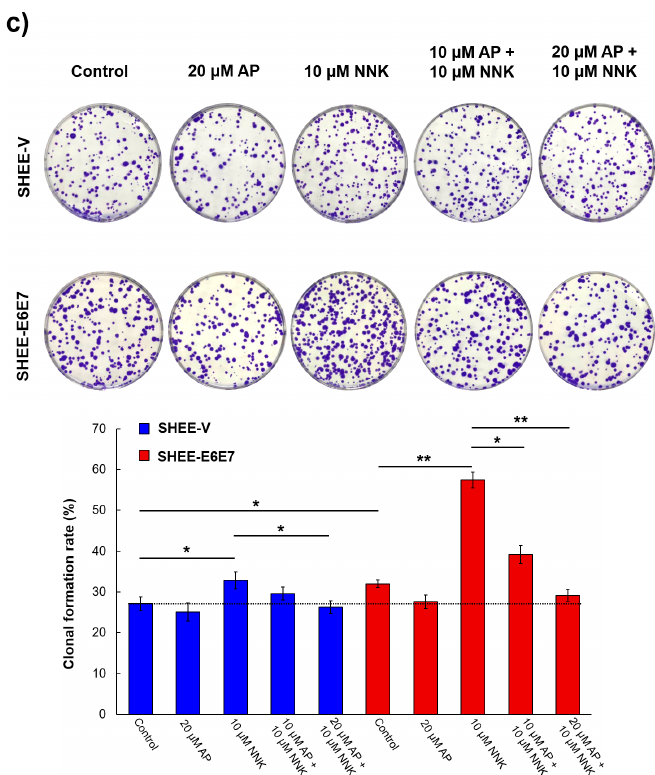
Figure 1. Apigenin (AP) inhibited the increased migration, invasion, and proliferation ability induced by the synergism of 4-(methylnitrosamino)-1-(3-pyridyl)-1-butanone (NNK) and human papillomavirus (HPV). ( a ) wound healing ability of immortalized human esophageal epithelial (SHEE) cells after 48-h NNK exposure with AP pretreatment (× 100); ( b ) cell invading capacity of SHEE cells after 24-h NNK exposure with AP pretreatment (× 200); ( c ) cell colony formation of SHEE cells after 24-h NNK exposure with AP pretreatment followed by a 7-day incubation. Data are presented as mean ± SD ( n = 3). * p < 0.05, ** p < 0.01, *** p < 0.001.